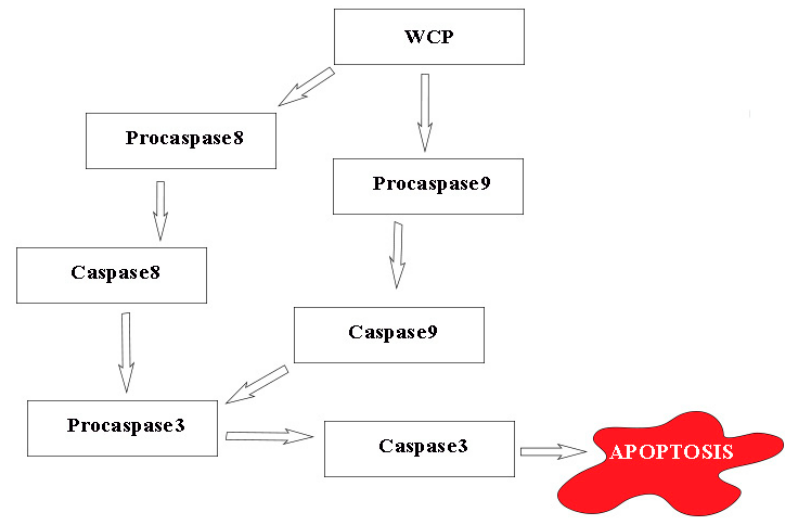
Figure 2. Proposed mechanism of the WCP-triggered, caspase-mediated apoptotic pathway in LNCaP cells, based on the results of the present study. Arrows indicate promoting.